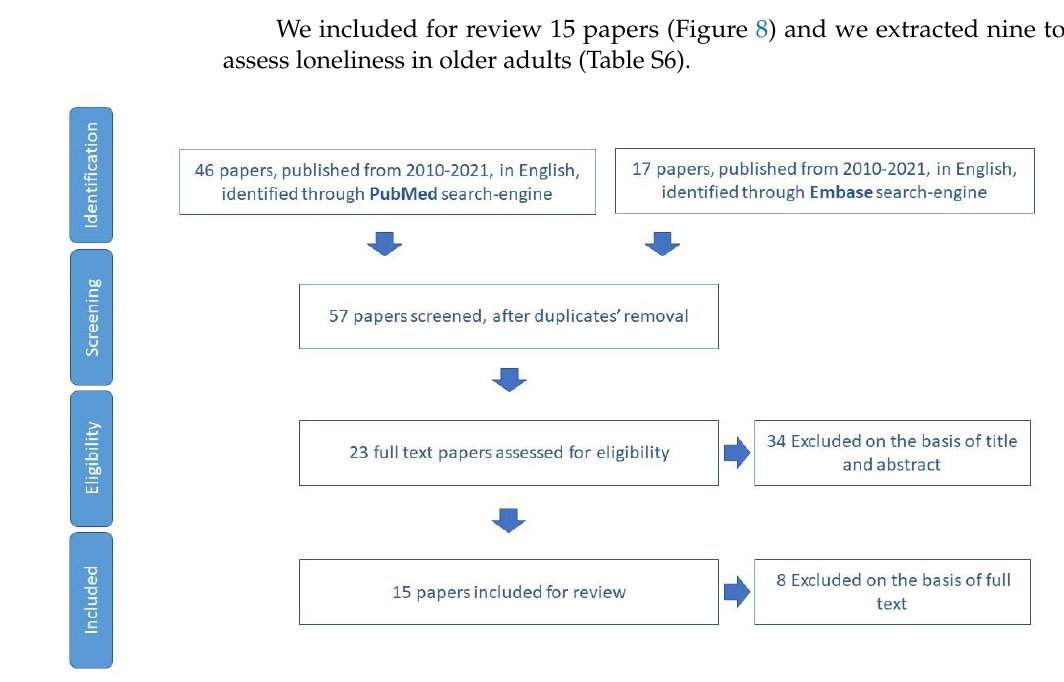
Figure 8. Process of study selection for the assessment of loneliness.